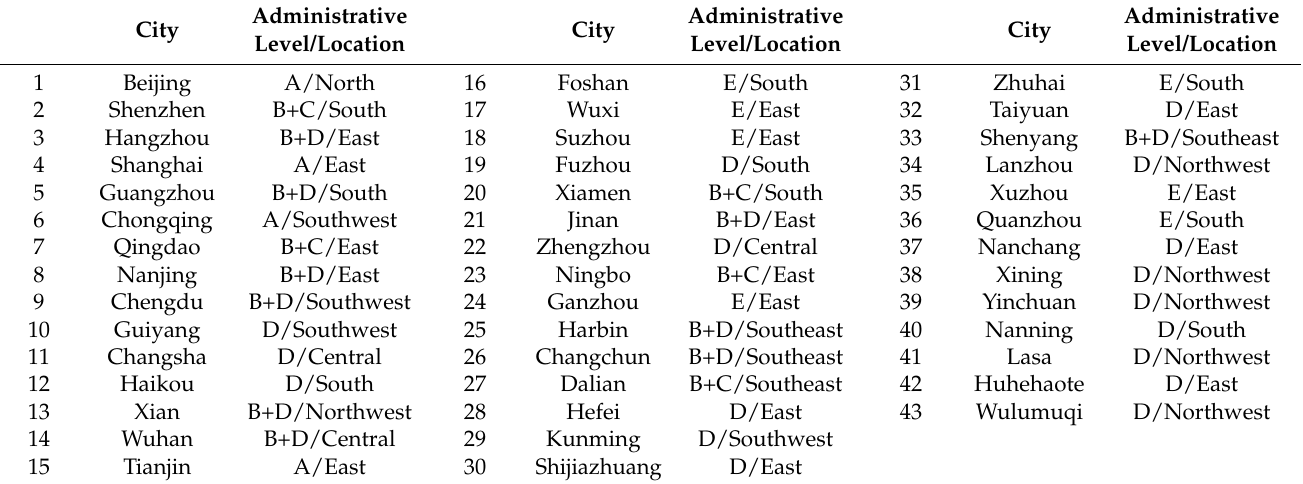
Table 1. List of sample cities.